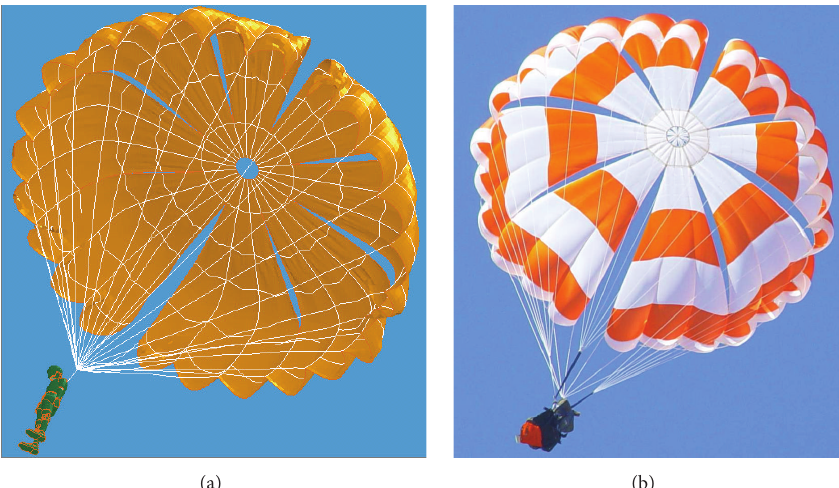
Figure 5: Comparison of parachute-load systems’ steady state ((a) is simulation results and (b) is experimental results).